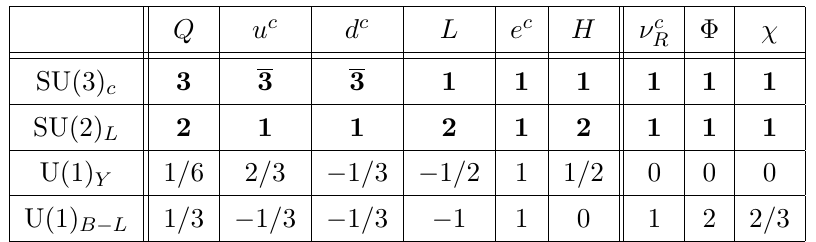
Table 1 . Particle contents and quantum charges of the